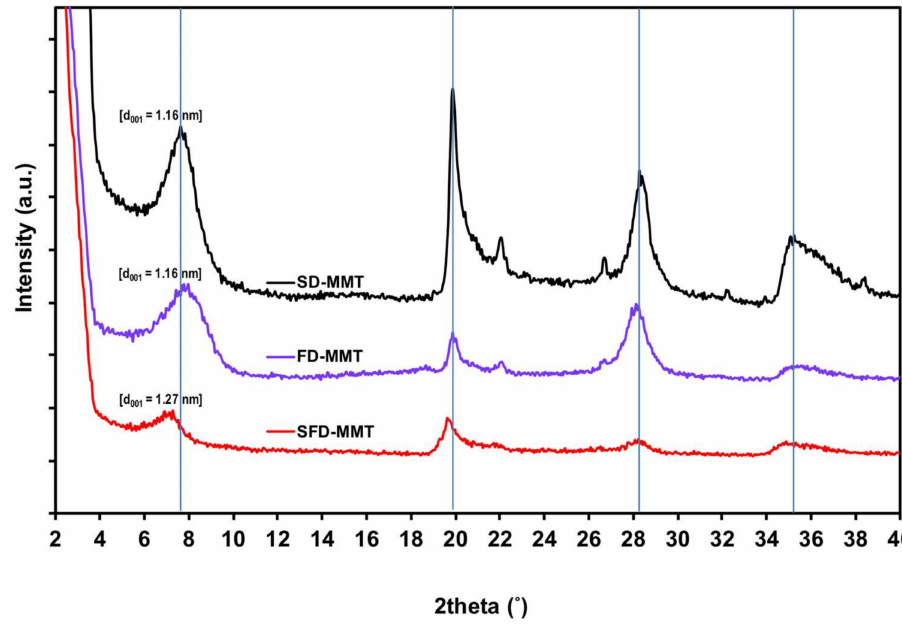
Figure 2. XRD diffractograms of MMT agglomerates: SD-MMT, FD-MMT and SFD-MMT.